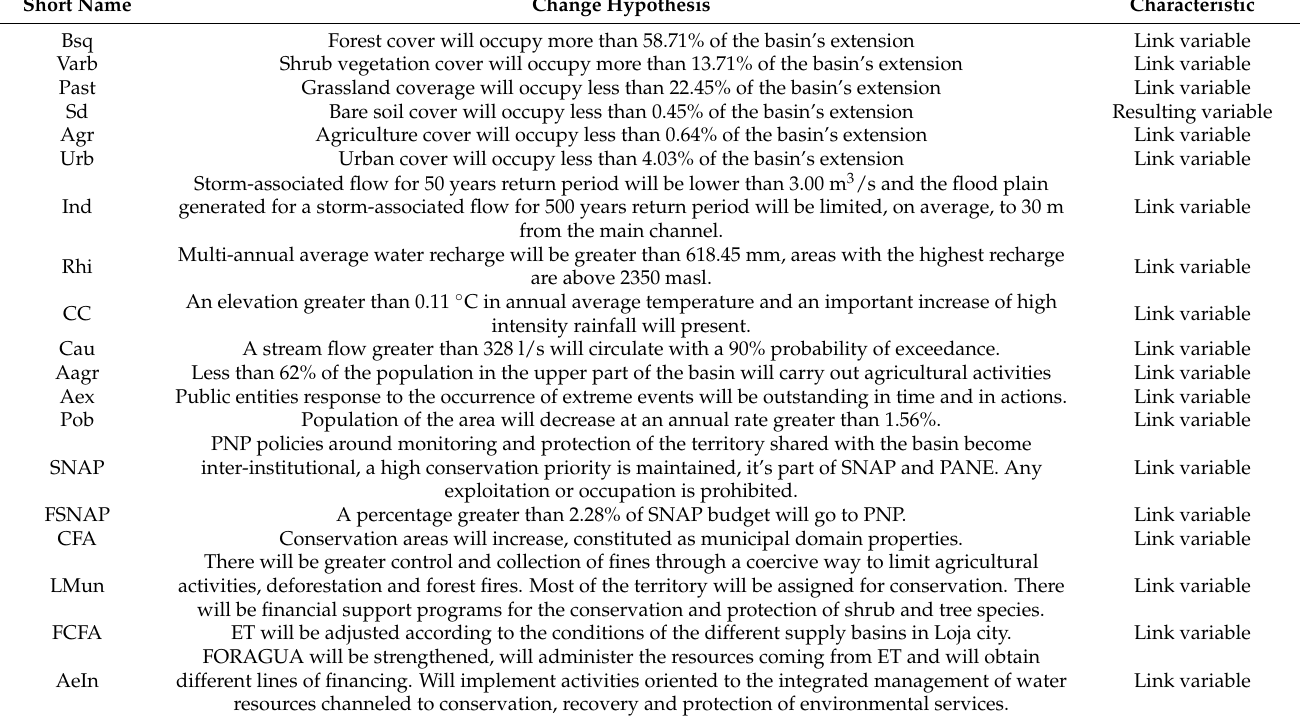
Table 3. Positive future change scenario, hypothesis by variable, and its characteristic.